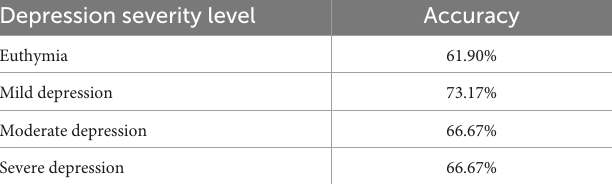
TABLE 6 Performance of MGMT in four-level depression severity classification